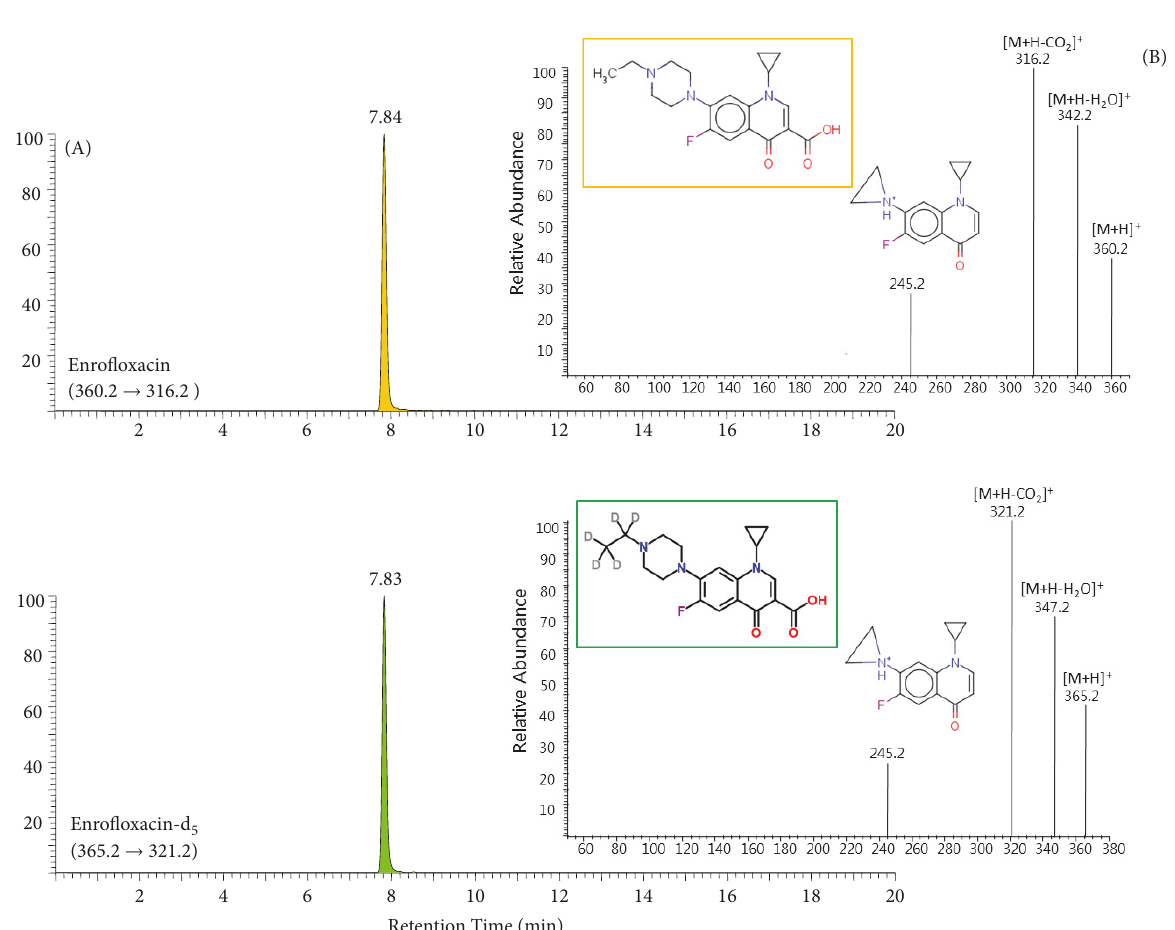
Figure 2: LC-ESI(+) MS/MS chromatogram (A) of enrofloxacin (upper panel) and enrofloxacin-d 5 (lower panel) and each individual full- scan product ion spectrum (B) extracted from chicken meat CRM. Table 1: Calibration curves and detection limits (LOD and LOQ) for individual laboratories. Lab